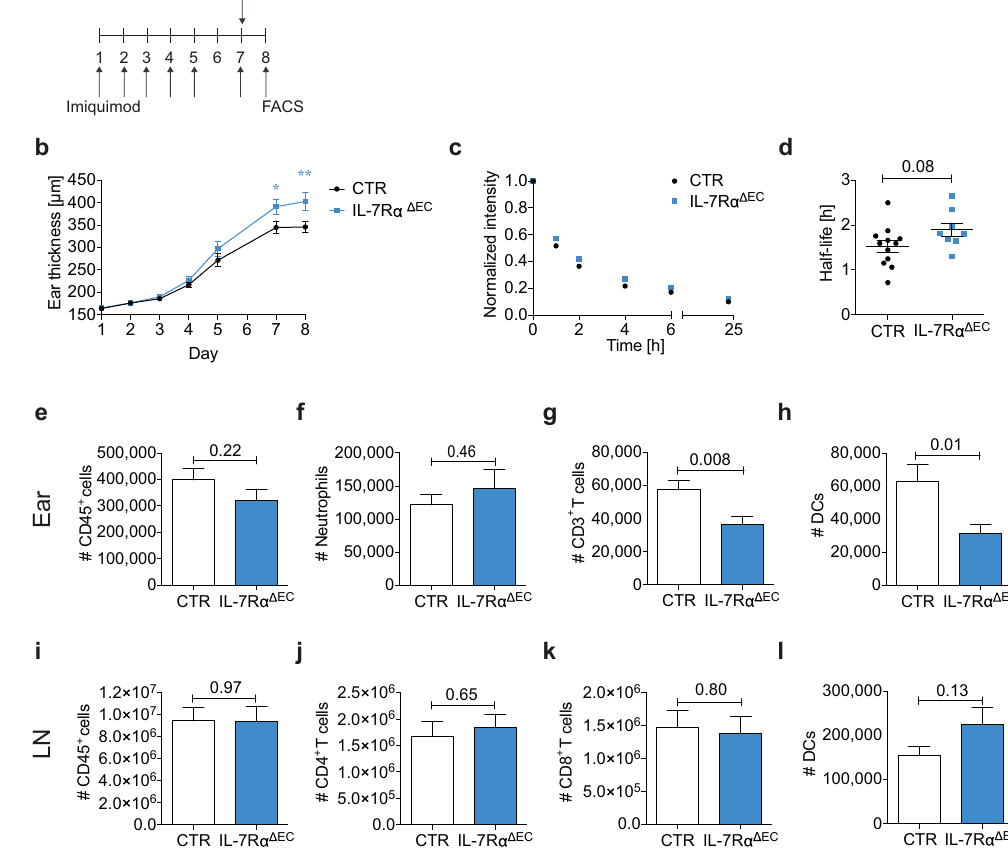
Figure 5. Endothelial-specific deletion of IL-7R α decreases lymphatic drainage and increases edema formation in imiquimod-induced inflammation. ( a ) Imiquimod-containing cream was applied to the ears of IL-7R α Δ EC and control (CTR) mice on days 1–5, and 7. The ear thickness was measured on each treatment day. Lymphatic drainage was measured on day 7 after challenge and the mice were sacrificed on day 8. The immune cell infiltration in the ear skin was analyzed by FACS. ( b ) Ear thickness measurements over the course of the treatment. * p < 0.05; ** p < 0.01. ( c , d ) Lymphatic drainage analysis: ( c ) Average clearance plots of P20D800 from the ear measured by IVIS and ( d ) the calculated half-lives. FACS-based quantification of the number of ( e , i ) CD45 + cells, ( f ) neutrophils, ( g ) CD3 + T cells, ( h , l ) DCs, ( j ) CD4 + T cells, ( k ) CD8 + T cells in ( e – h ) the ear skin and ( i – l ) dLNs on day 8. The average number of immune cells per ear is shown. Pooled data (mean ± SEM) from 3 experiments with a total of 17–18 mice per group ( b , e – l ) and pooled data from 2 experiments with 8–12 mice per group ( c , d ) are